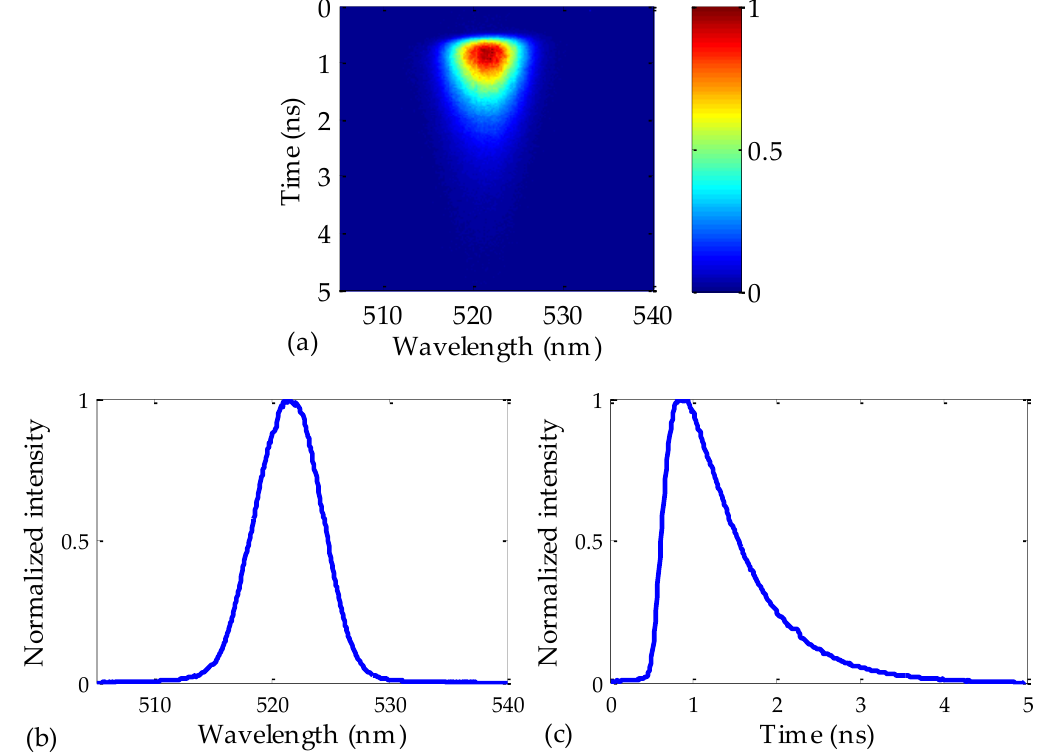
Figure 2. ( a ): Pseudo-3D Streak image obtained when a 50 m Toray fiber is excited at 520 nm with 9 nW of average power; ( b , c ): Respectively, spectral (time-integrated) and temporal (wavelength-integrated) images.